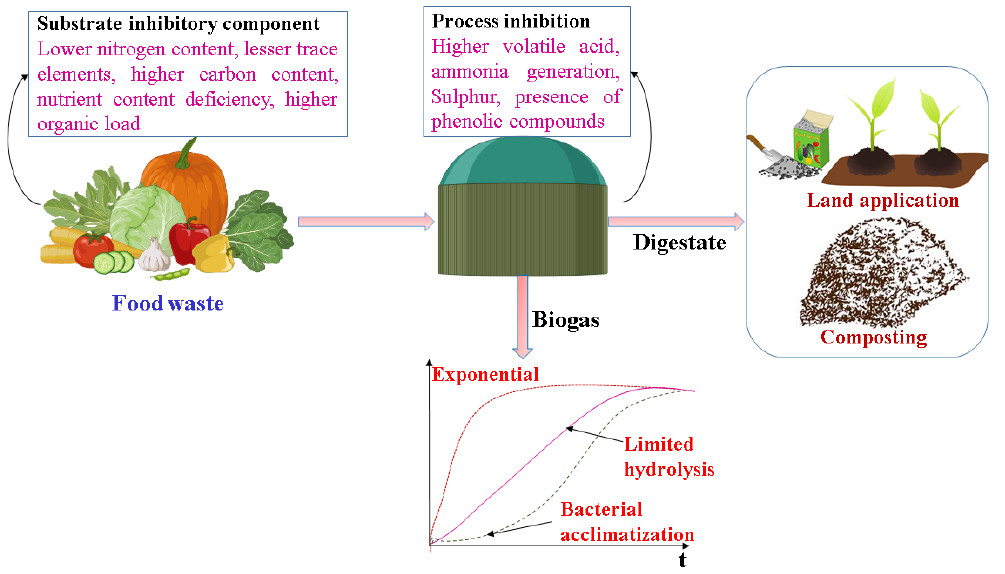
Figure 1. Inhibitory compounds affecting the digestion